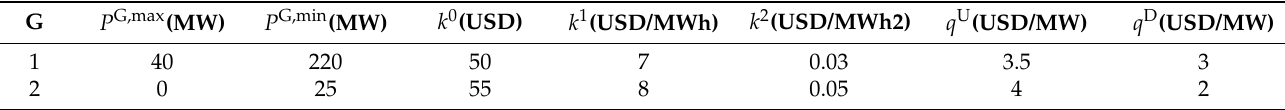
Table A8. Generator